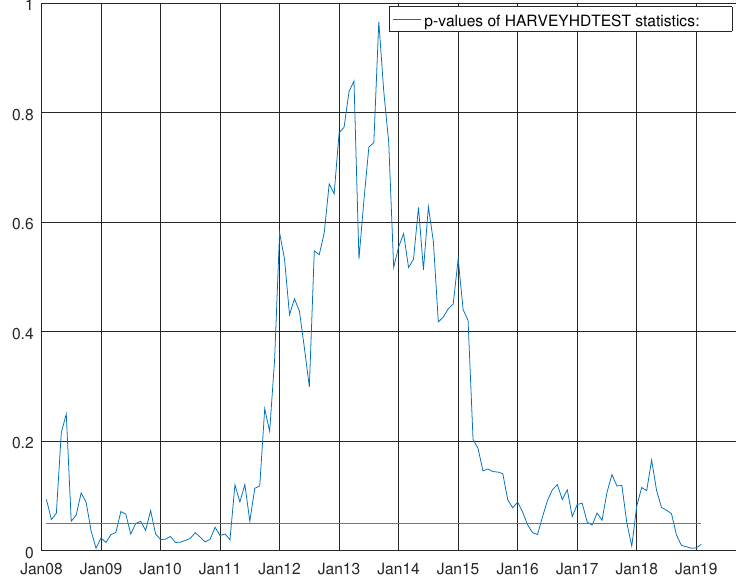
Figure 14. Graph showing the p -values of the Durbin–Watson test for the enhanced model for intermediate goods. The null hypothesis states that residuals are not autocorrelated.